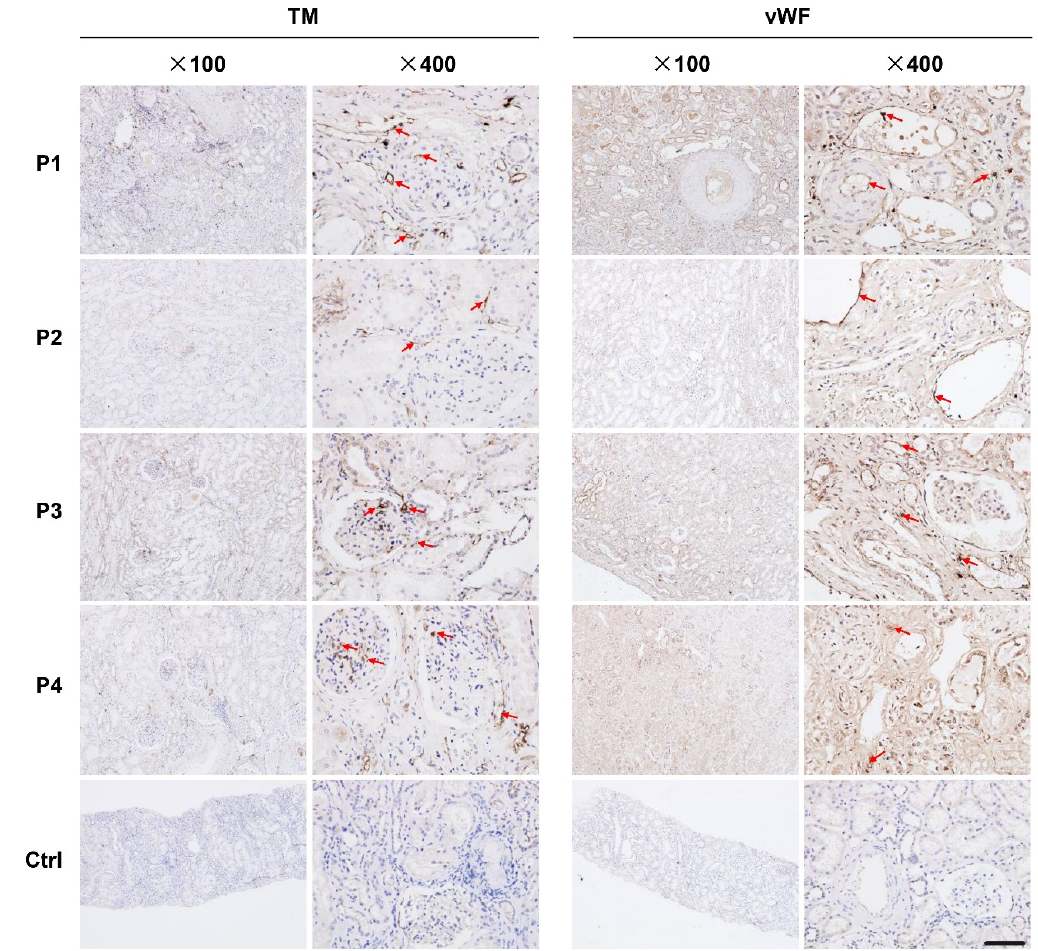
Figure 4. Histopathological examinations of endothelial lesion in kidney tissues. IHC staining of endothelial lesion markers of TM and vWF in kidney sections from dead COVID-19 patients after autopsy. TM and vWF expression in kidney tissues from four dead COVID-19 patients were observed under light microscope at 100- or 400-times magnification. Arrow indicated the positive staining cells. The adjacent renal tissue from the resected kidney from one patient with renal carcinoma was also stained as a control. TM: thrombomodulin; vWF: von Willebrand factor.